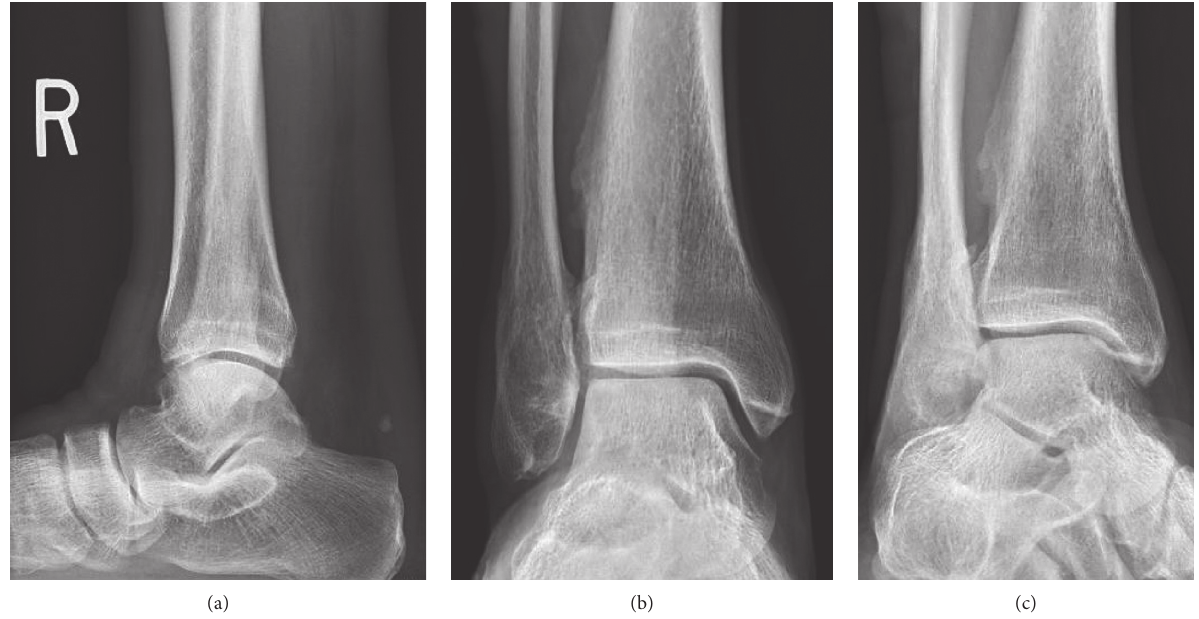
Figure 2: Plain radiographs: (a) lateral view, (b) anteroposterior view, and (c) mortise